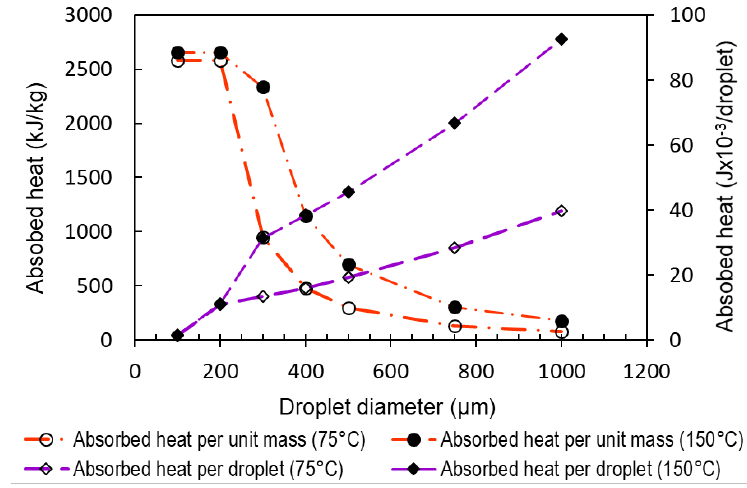
Figure 11. Absorbed heat by the droplets with different initial diameters for condition 1 and 2.